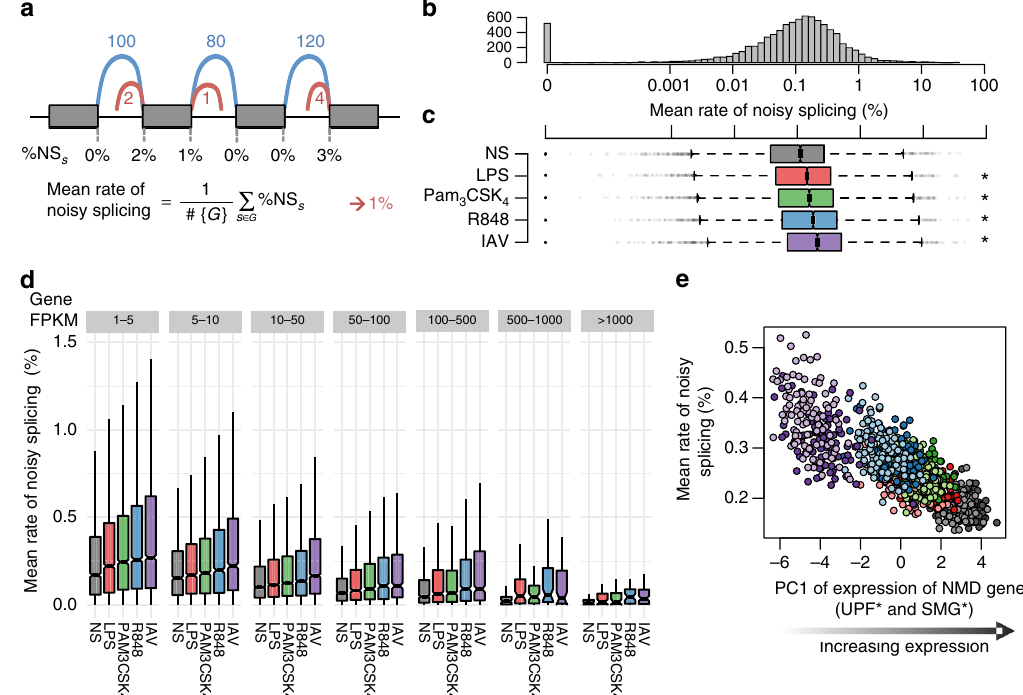
Fig. 3 Increase in noisy splicing upon immune stimulation. a For each constitutive splice site neighbouring a coding exon, functional splicing events (blue) that join two exons are distinguished from non-functional splicing events (red) where the splice site is joined with a cryptic, non-conserved splice site (GerpRS < 2). For each gene, the mean rate of noisy splicing was computed as the average across all constitutive splice sites of the frequency at which non- functional splicing events occur. b Distribution of the rate of noisy splicing at the basal state. c Distribution of the levels of noisy splicing per gene according to the condition of stimulation (centre line, median; box limits, upper and lower quartiles; whiskers, 1.5× interquartile range; points, outliers). The signi fi cance of differences between noisy splicing in each stimulation condition and the basal state was assessed by a Wilcoxon rank test (* p < 10 − 20 ). d Distribution of the rate of noisy splicing per gene as a function of gene expression. For each bin of expression, the rate of noisy splicing is shown across all conditions of stimulation (boxplots drawn as previously). e Average rate of noisy splicing per sample correlates with expression of nonsense-mediated decay genes ( fi rst PC). For each sample, the colour re fl ects the condition of stimulation (grey: NS, red: LPS, green: Pam 3 CSK 4 , blue: R848, purple: IAV). Light and dark shades indicate European and African individuals respectively. Source data are provided as a Source Data fi